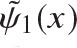
Behavior of the cumulative pre-factors ψ˜1x (panel A) and ψ˜2x (panel B) of the disturbing function due to a power-law disc (p = 1, q = 0.5 and ain → 0, aout → ∞) with softened gravity, shown as a function of x — relative separation between a given test-particle orbit and the nearest neighboring disc rings. Formalisms of Hahn (2003), Touma (2002), Tremaine (1998) and Teyssandier & Ogilvie (2016) are shown by different colors as indicated in panel (A), for different values of softening (shown by different line types). The purple lines represent results obtained by the unsoftened expressions of Davydenkova & Rafikov (2018) (DR18) based on the Heppenheimer method (see §6.3). Insets illustrate the behavior as x → 0 for the three convergent softened formalisms — see text (§3.2) for more details.